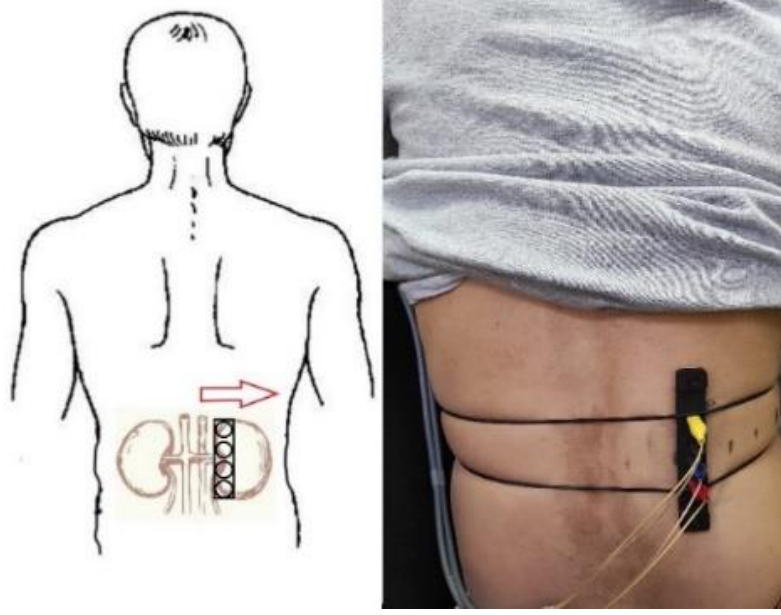
Figure 6. The electrode system position corresponding to the projection of kidney on skin surface.